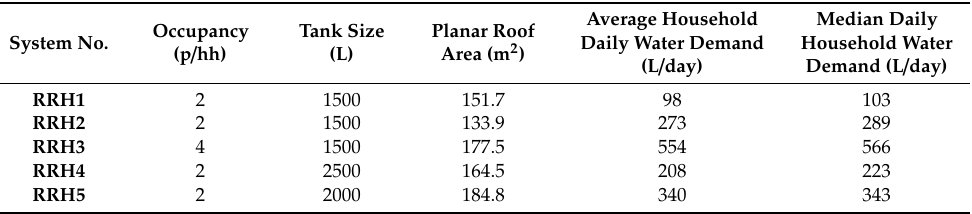
Table 1. Roof runoff harvesting (RR system characteristics.